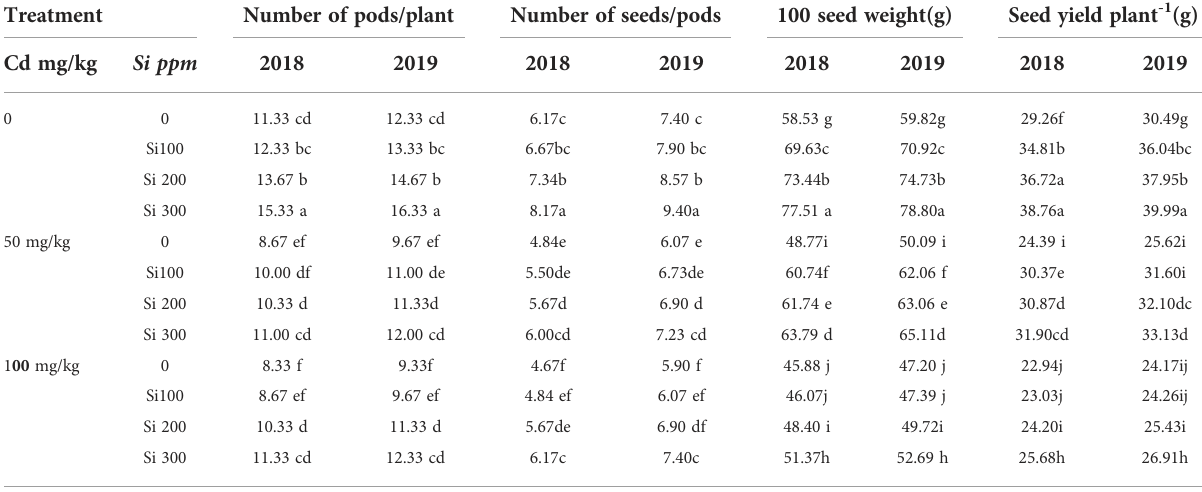
TABLE 3 Effect of foliar application of silicon on pea (yield and yield components characteristics) grown in different concentrations of cadmium (Cd) during 2018/2019 and 2019/2020 growing seasons. Treatment